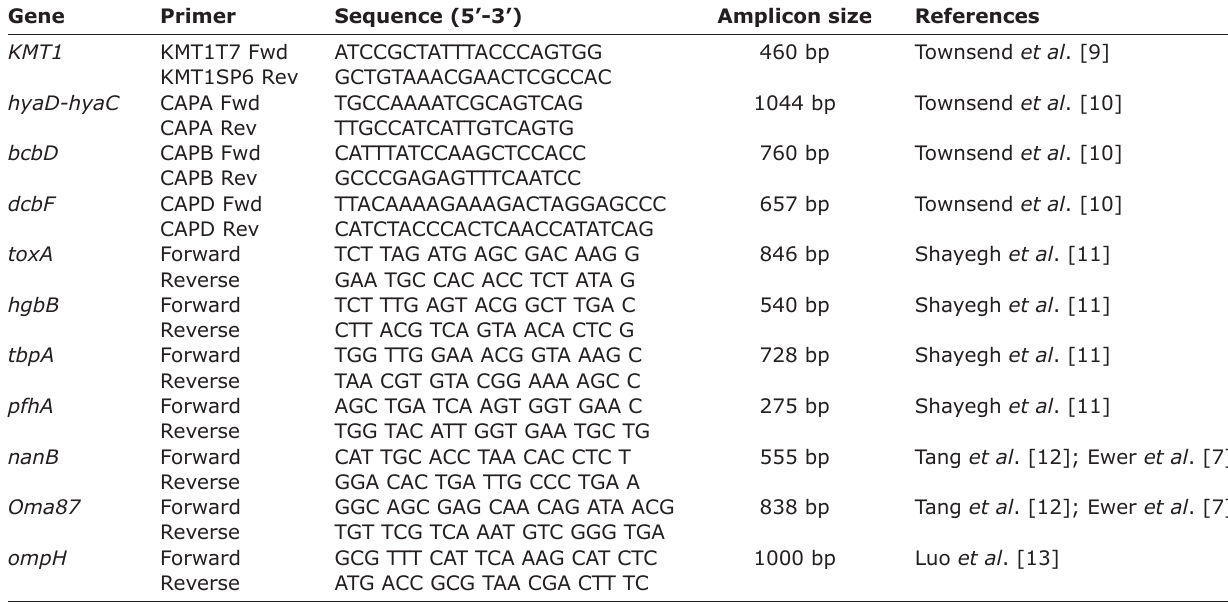
Table-1: Sequences of the oligonucleotides used in the P. multocida multiplex capsular and virulence-associated genes typing assay of P. multocida .